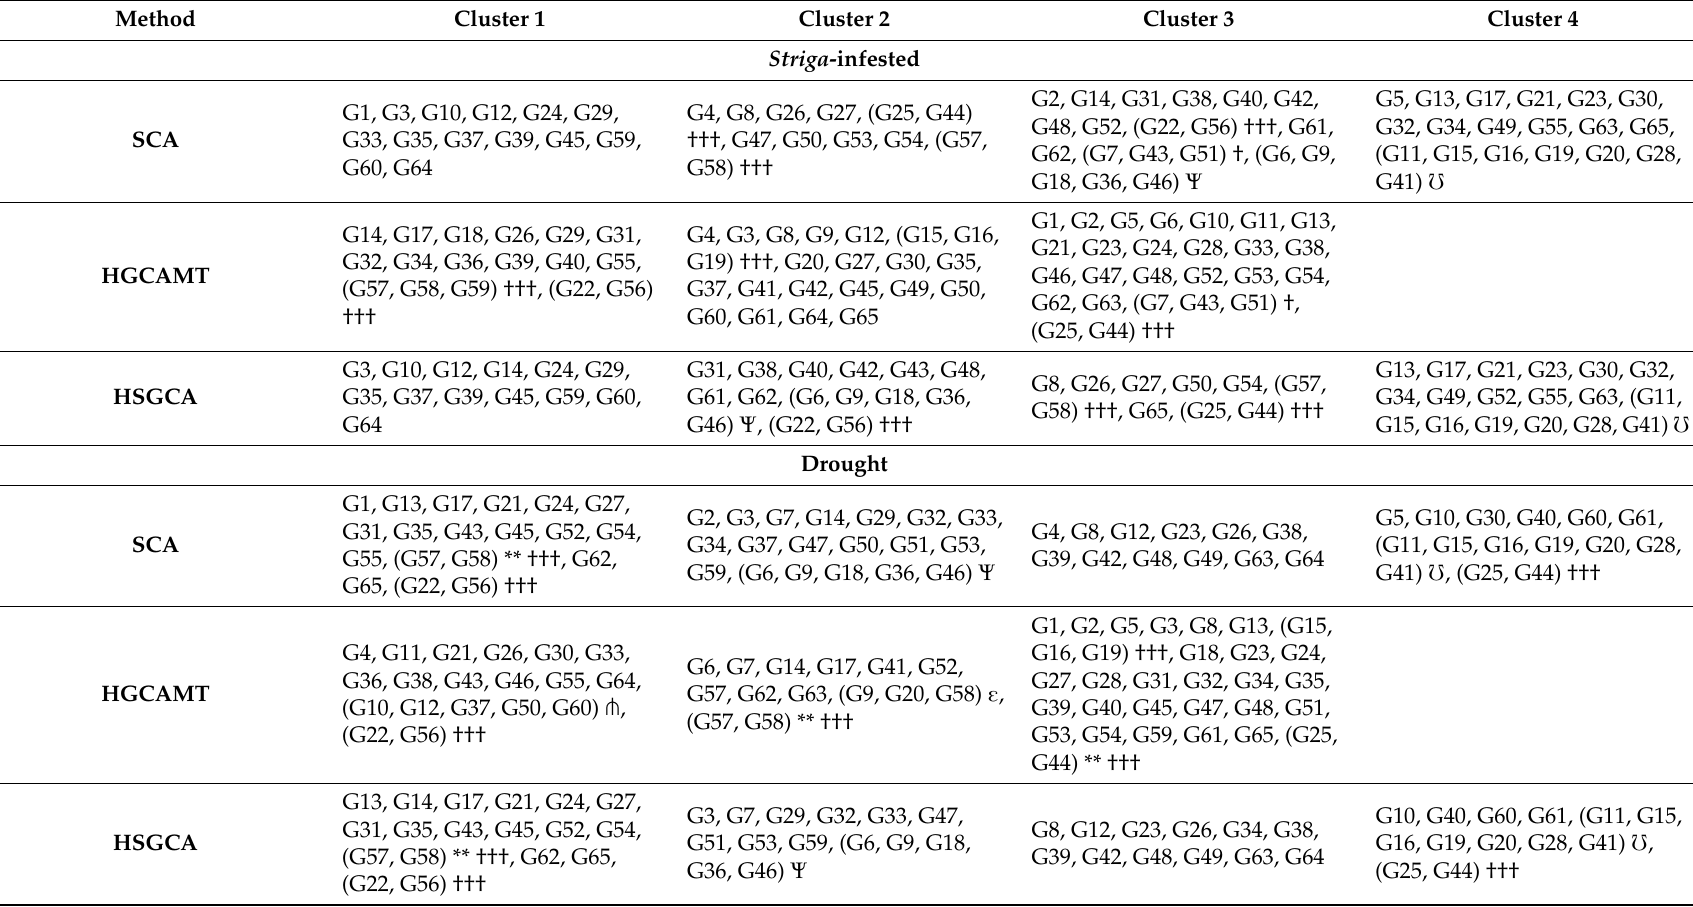
Table 6. Summary of the classification of maize inbred lines by SCA, HGCAMT, HSGCA, and SNP-GD methods under Striga -infested, drought, and combined